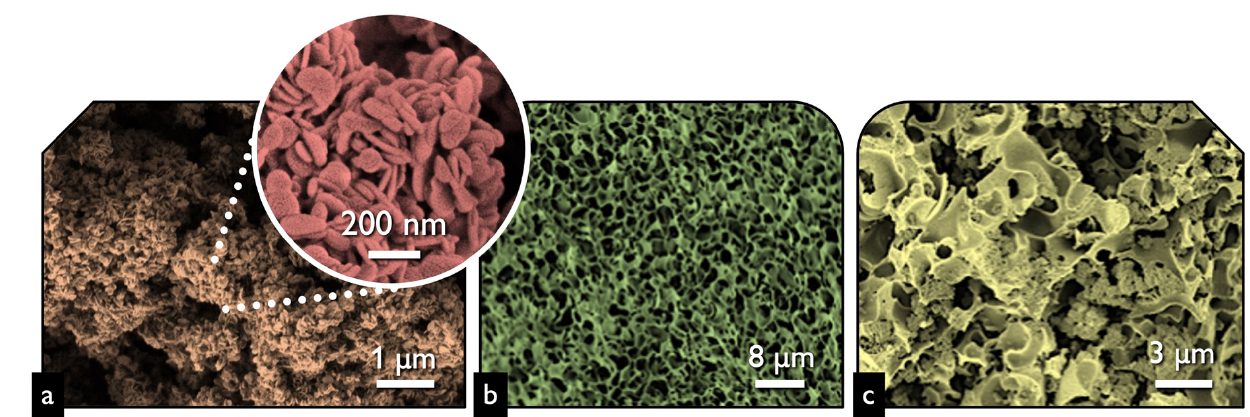
Figure 1. The SEM image of BiOCl ( a ), lignin-derived biochar ( b ), and BiOCl-biochar composite 15BCPC ( c ).